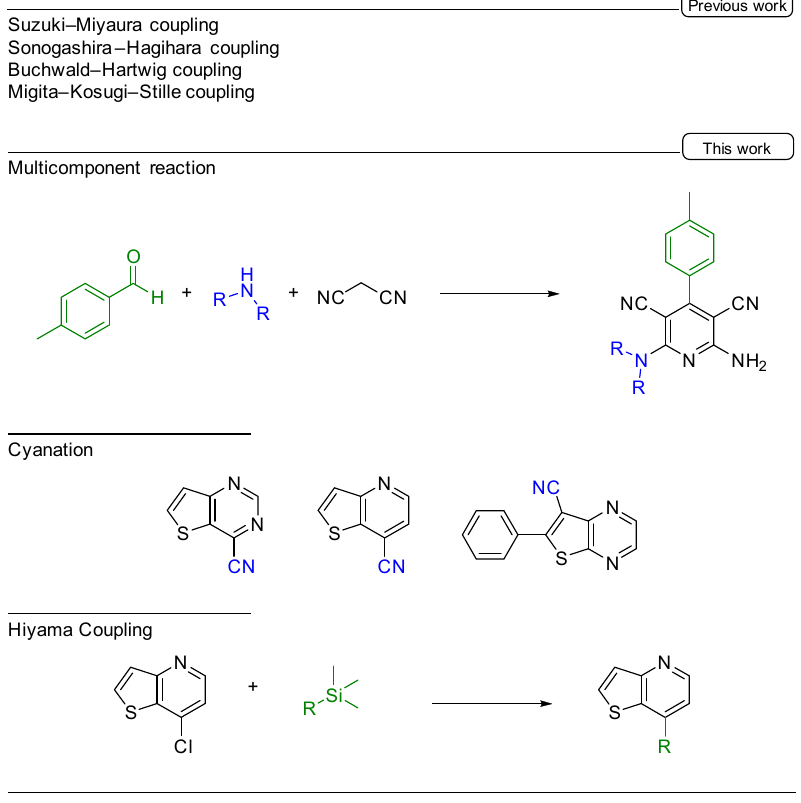
Figure 1. Eucalyptol as bio-based solvent: application to Hiyama coupling, cyanation and multicomponent reactions.